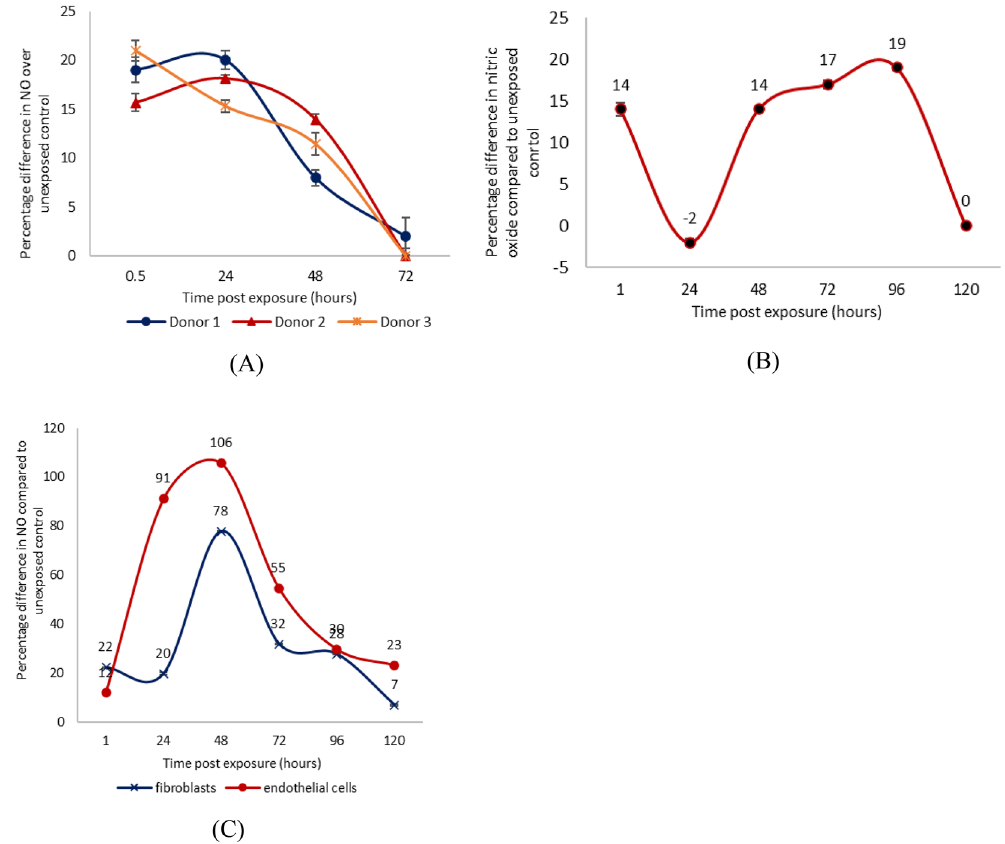
Figure 3. Increase of nitric oxide in primary human skin cells due to exposure 9 J/cm 2 of UV-A compared with unexposed control cells at various time points after exposure. ( A ) Keratinocytes derived from three independent neonatal donors. ( B ) Keratinocytes derived from skin of adult donor. ( C ) Fibroblasts and endothelial